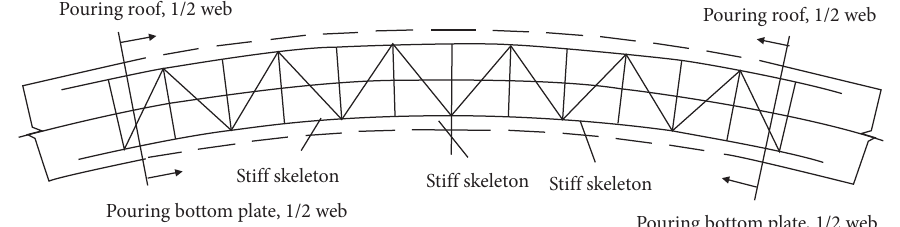
Figure 13: Sequence diagram of the longitudinal pouring of the outer concrete on the top of the arch